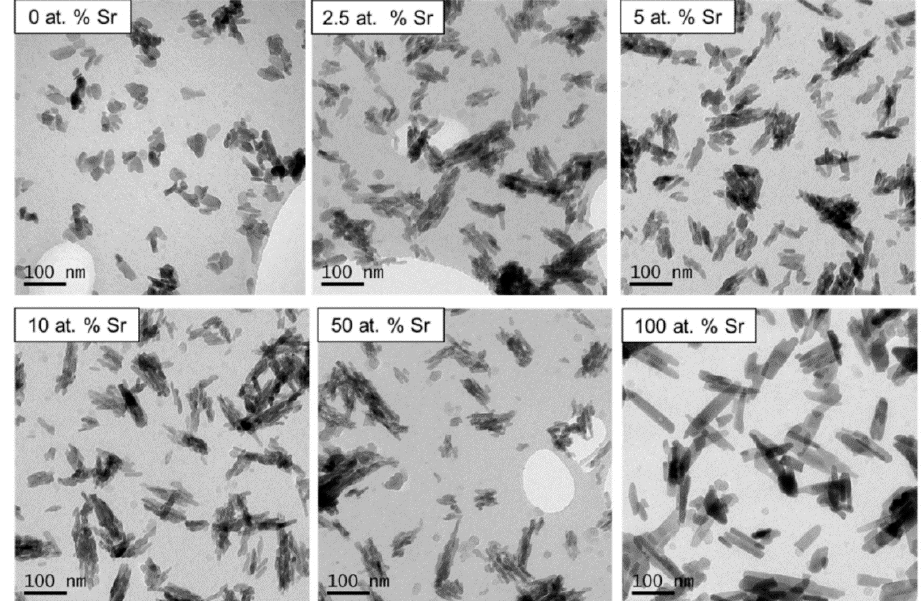
Figure 2. TEM micrographs of unsintered SrHA powders (0, 2.5, 5, 10, 50 and 100 at.% Sr) produced using the wet precipitation method.